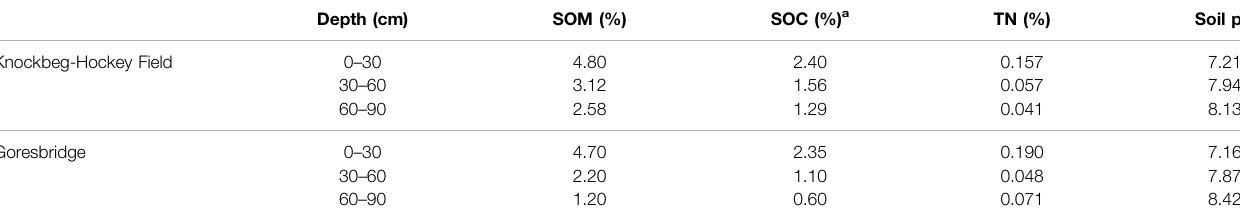
TABLE 2 | Soil chemical properties for each site. Depth (cm) SOM (%) SOC (%) a TN (%) Soil pH